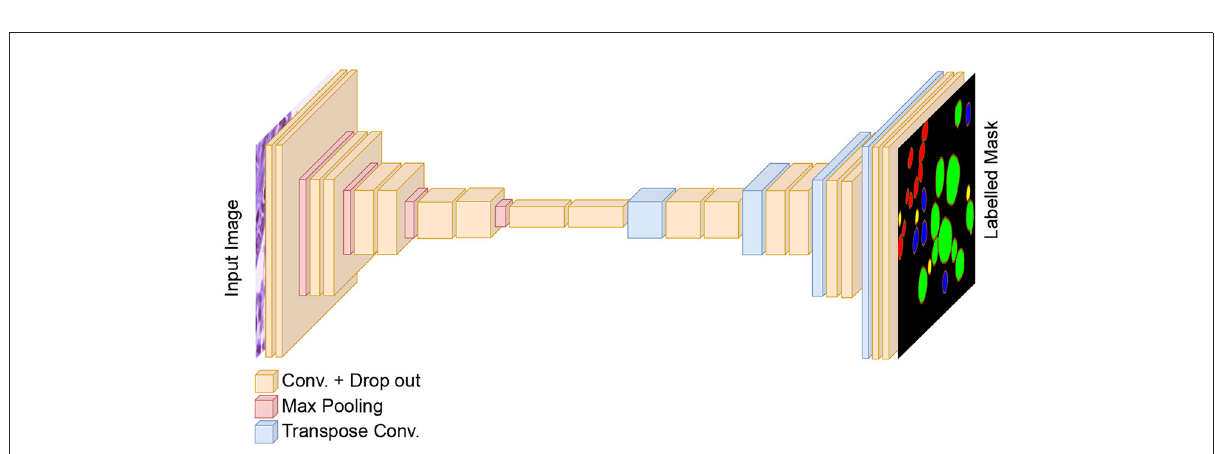
FIGURE4 The architecture of the classification model for nuclei instance categorization. The different colors in the output represent the nuclei classes in the MoNuSAC dataset. For simplicity, skip connections between the encoder and two decoders are not shown.